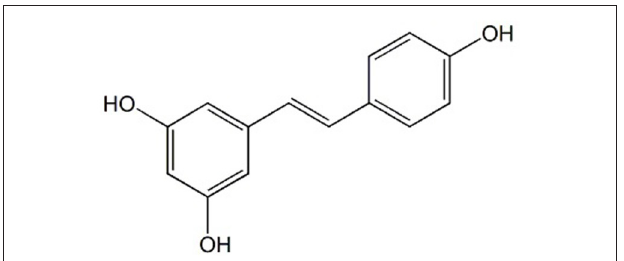
FIGURE 2 | Chemical structure of